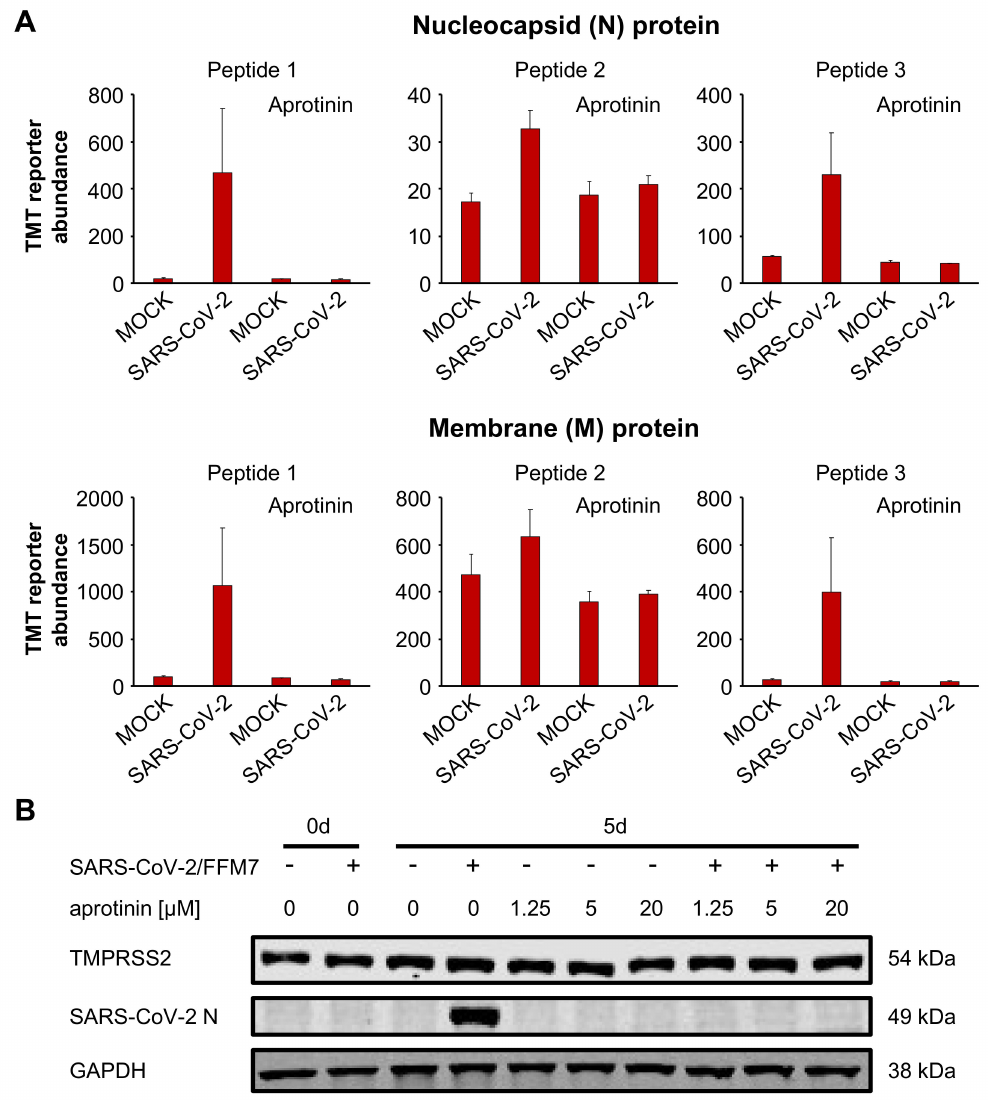
Figure 5. Antiviral e ff ects of aprotinin in SARS-CoV-2-infected air–liquid interface (ALI) cultures from primary bronchial epithelial cells. ( A ) Abundance of the SARS-CoV-2 proteins N (nucleocapsid) and M (membrane) in primary bronchial epithelial cell ALI cultures infected with SARS-CoV-2 / FFM1 (MOI of 1) in the presence or absence of aprotinin (20 µ M) as determined 5 days post-infection by multiplexed mass spectrometry analysis using acquisition targeting of previously identified viral peptides modified with TMTpro. The detailed data are presented in Table S1. ( B ) Western blots indicating cellular SARS-CoV-2 N and TMPRSS2 levels in primary bronchial epithelial cell ALI cultures infected with SARS-CoV-2 / 7 / Human / 2020 / Frankfurt (FFM7) (MOI of 1) in the presence or absence of aprotinin as detected 5 days post infection. GAPDH was served as the loading control. Uncropped Western blots are shown in Figure